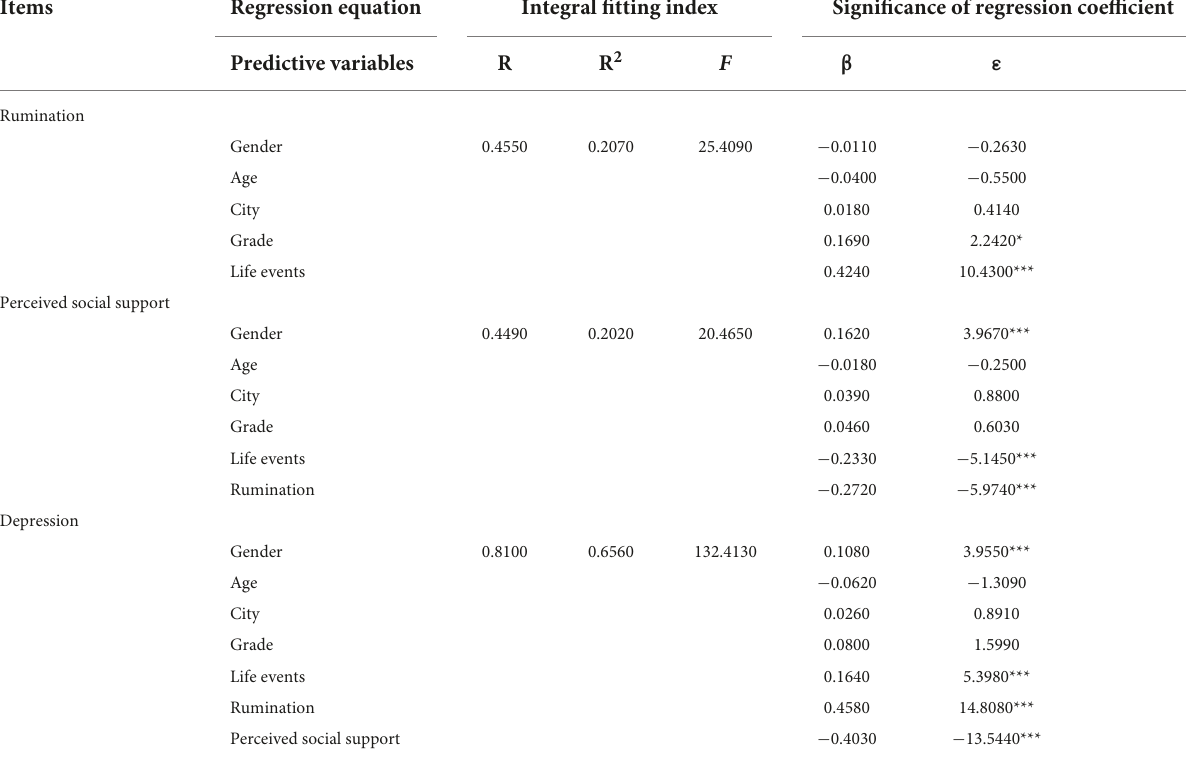
TABLE 2 Regression analysis results between variables.